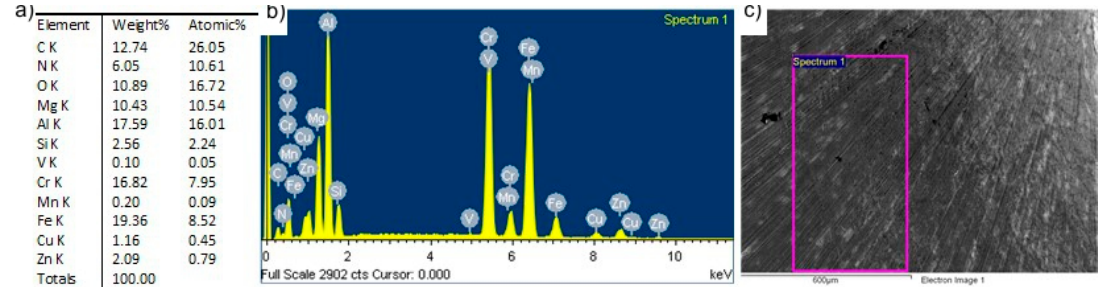
Figure 9. SEM/EDS analysis of chemical composition of the shoulder surface of the tool with the AlCrN coating after the second stage of testing: ( a ) content of elements, ( b ) EDS spectrum, ( c ) surface analyzed.